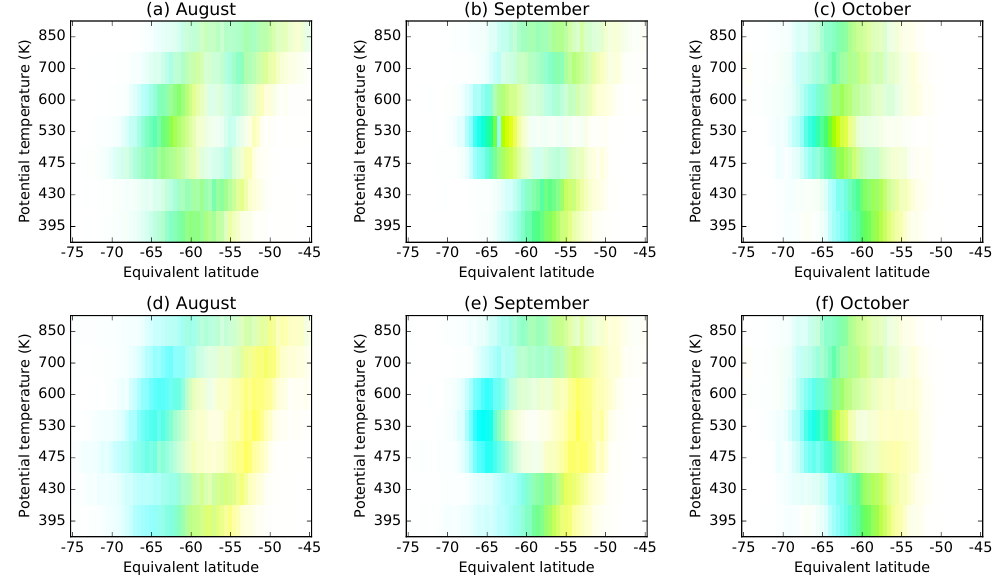
Figure 12. Location of inner (cyan) and outer (yellow) edges of the vortex boundary region at ERA-Interim levels between 395 and 850K, 1979–2016, defined using (a–c) the criteria of Nash et al. (1996) and (d–f) accounting for secondary peaks in PV gradient using the bifur- cation algorithm presented here. The intensity of cyan and yellow represents the frequency of inner and outer boundaries in each 0.5 ◦ bin, respectively, with green colours indicating a mix of both inner and outer boundaries at different times. The frequency per bin is scaled with respect to a maximum count of 600 per